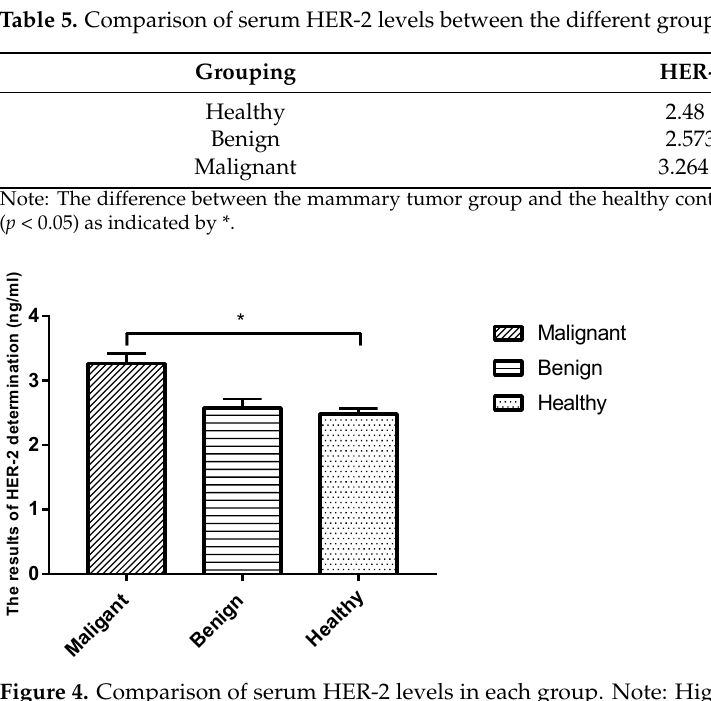
Figure 4. Comparison of serum HER-2 levels in each group. Note: Highly significant ( p < 0.05) as indicated by *.